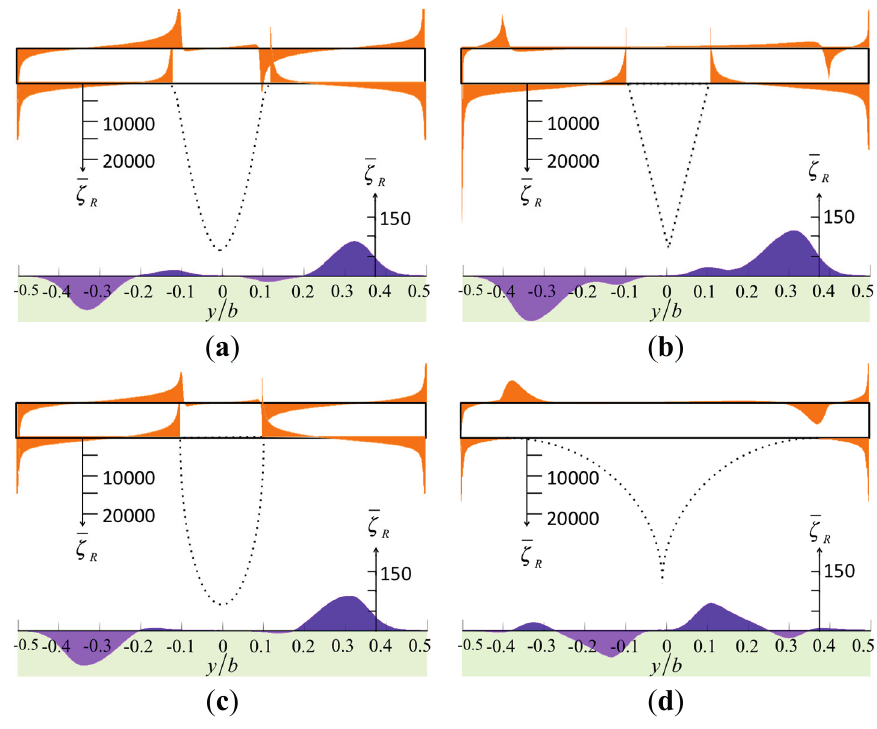
Figure 2. The normalized vorticity in real part over the surfaces of the cantilever and the specimen caused by various tip shapes: ( a ) the sharp model; ( b ) the sine-shaped model; ( c ) the cone-shaped model; and ( d ) the bell-shaped model.